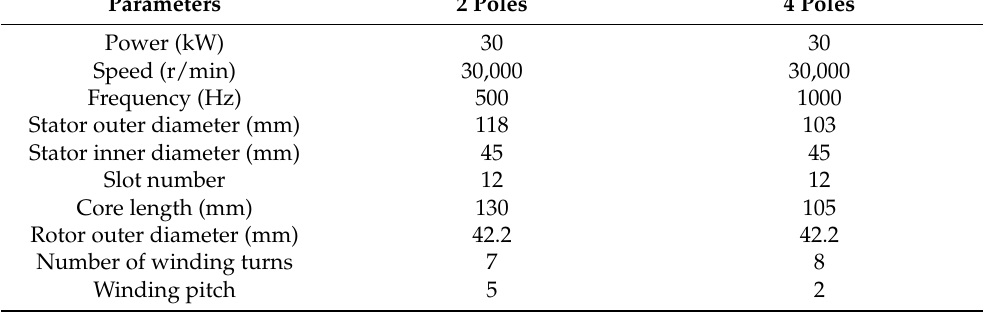
Table 2. Structural parameters of 2 and 4 poles HSPMMs.